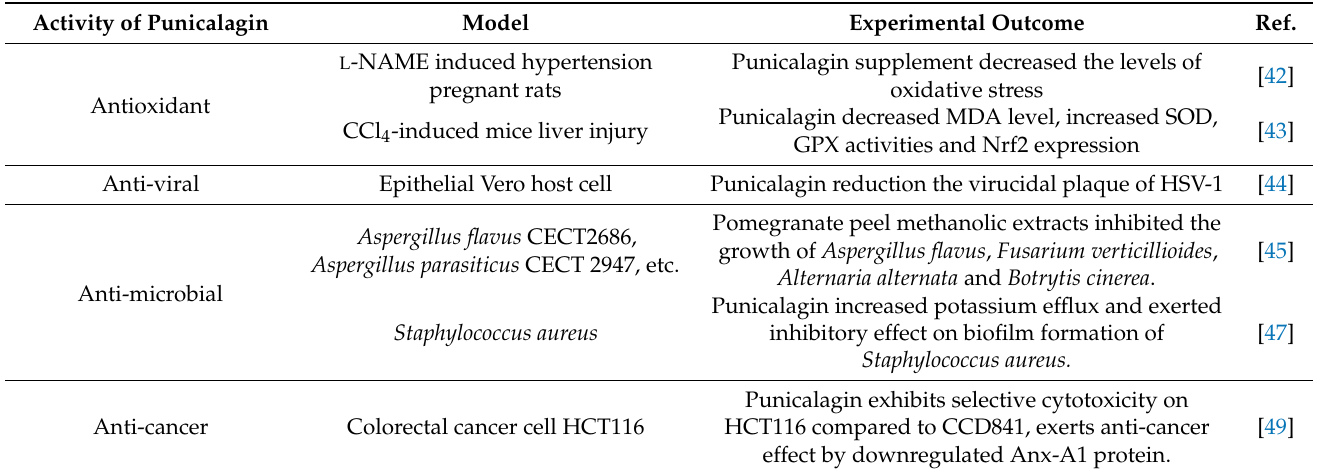
Table 2. The biologic effect of